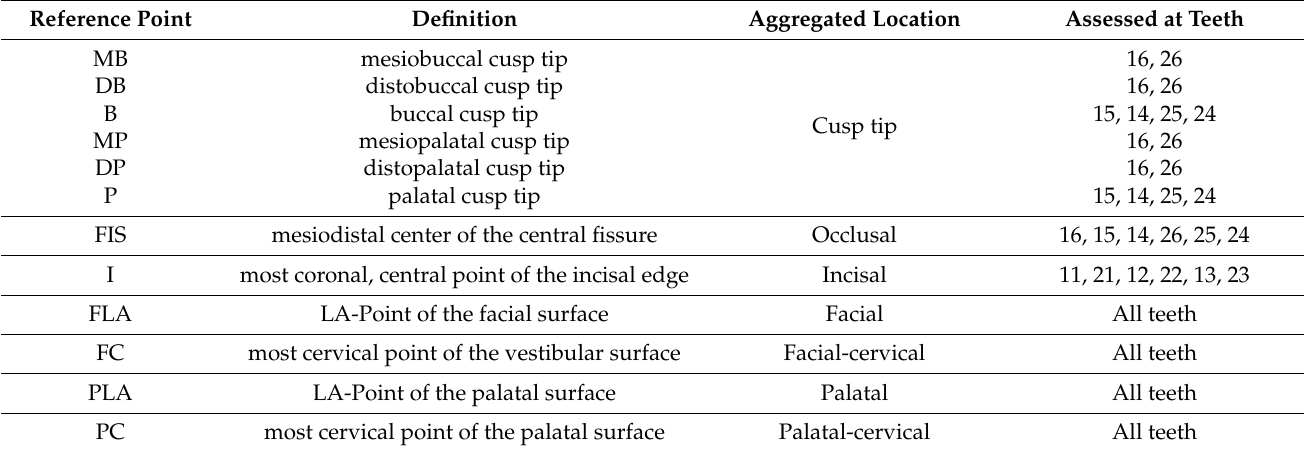
Table 1. Reference points for assessment of local aligner material thickness values. The column “aggregated location” specifies which values were aggregated per group (high/narrow) or tooth type (molar/premolar/canine/front), respectively. The right column specifies the teeth at which the thickness measurements were